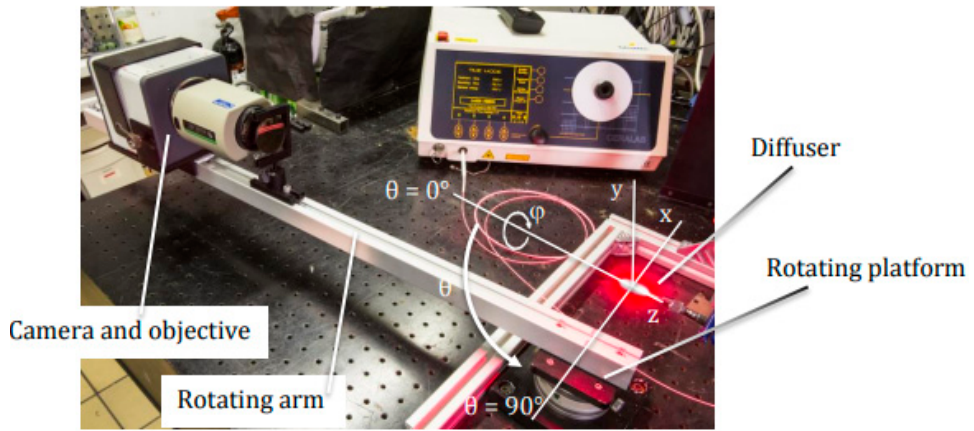
Figure 2. Goniometer setup: rotating platform, mechanical arm with EM-CDD camera, neutral density filter and di ff user holder. The polar angle θ (corresponding to the rotation of the camera around the vertical axis) and the azimuthal angle ϕ (obtained by measuring the radiance at di ff erent